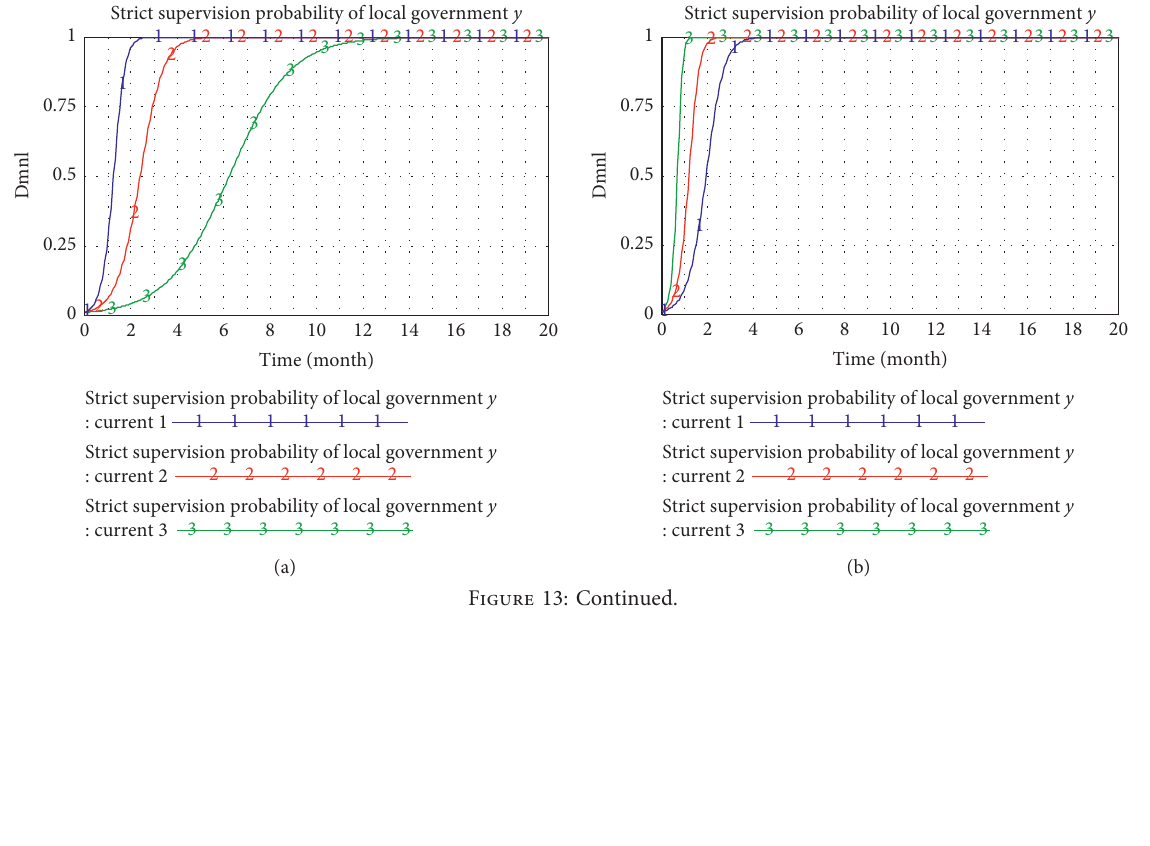
Figure 12: The impact of external variables on the strategic choice of functional departments: (a) Current 1: C Current 3: C 3 � 8; (b) Current 1: C 4 � 2, Current 2: C 4 � 3, and Current 3: C 4 � 4; (c) Current 1 : P 2 � 2, Current 2: P 2 � 5, and Current 3: P 2 � 8; (d) Current 1 : P 4 � 3, Current 2 : P 4 � 5, and Current 3 : P 4 � 7; (e) Current 1: β � 0.1, Current 2: β � 0.4, and Current 3 : β �